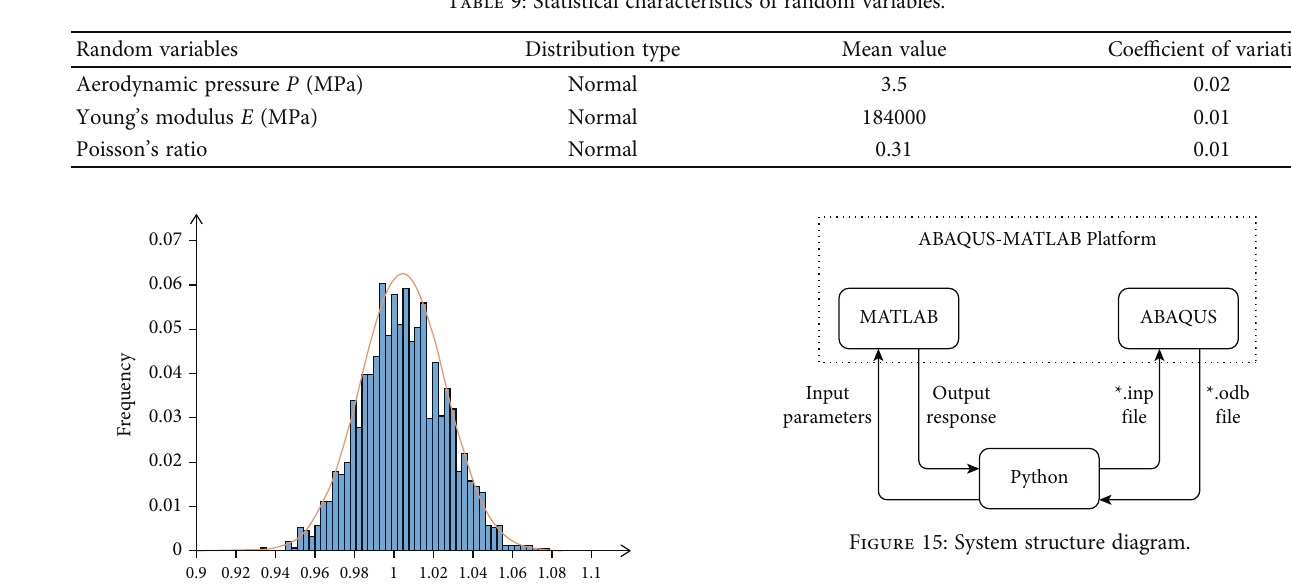
Table 9: Statistical characteristics of random variables.